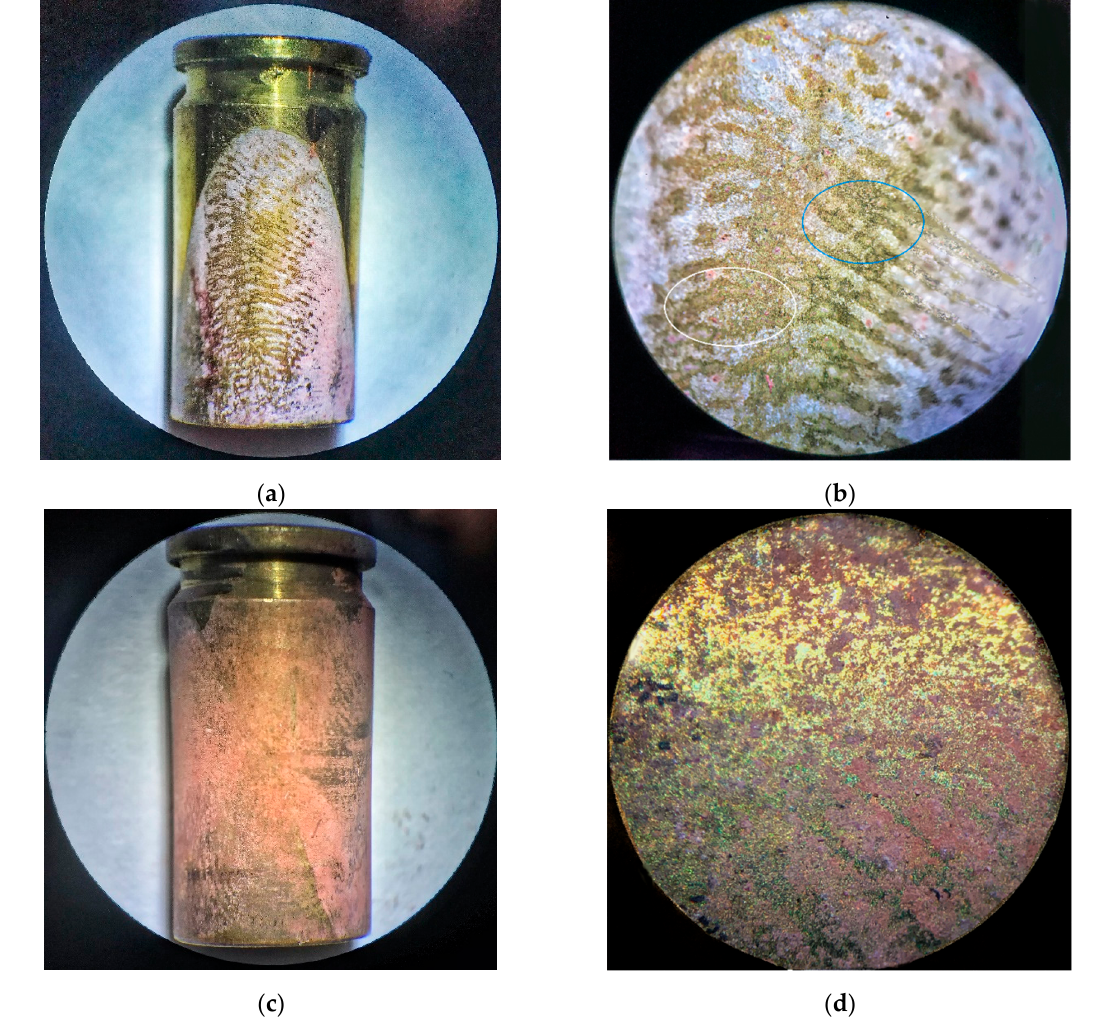
Figure 7. Visualized fingerprints on fired brass cartridges. Images were taken with a binocular magnifier: ( a , c ) 10× magnification and ( b , d ) 30× magnification. Comparison of two different fingerprints: ( a , b ) relatively quality fingerprint with marked details (cross (marked in blue) and fork (marked in white)) and ( c , d ) partial (poor-quality) print; both prints applied before firing (unknown shooters).